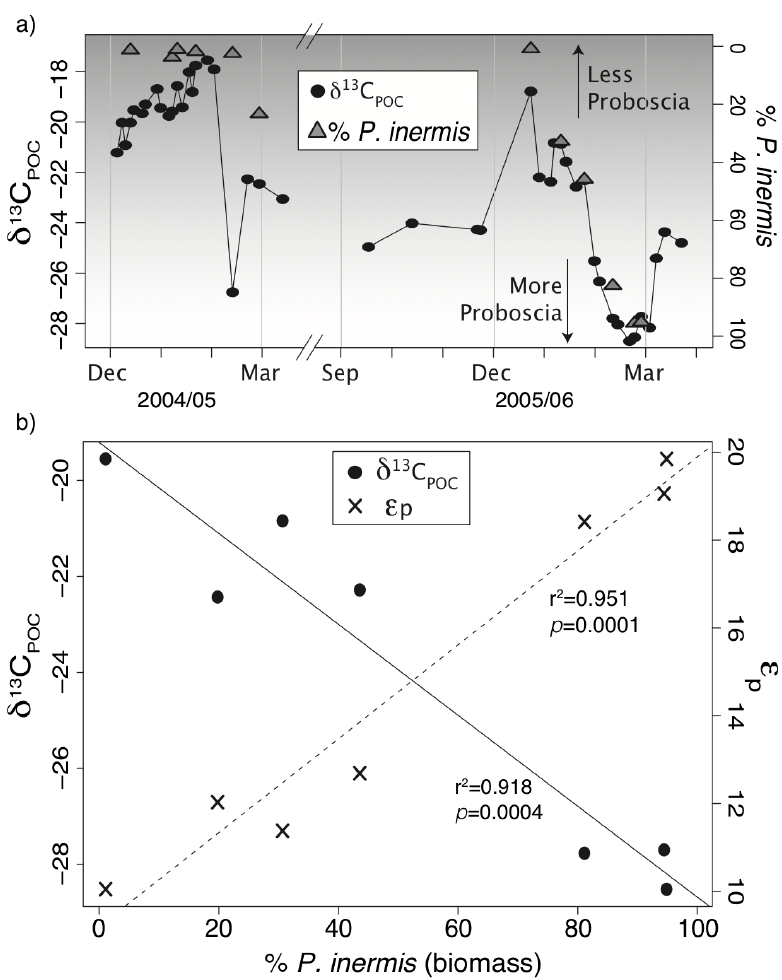
Fig. 10. Comparison of the fraction of surface water diatom biomass made up of P. inermis (triangles), δ 13 C POC (circles; solid line) and ε p (crosses; dashed line) for 2004/05 and 2005/06. Time-series data is shown in (a) , note the reversal of the right hand y-axis (% P. inermis ) to better illustrate the coupling between P. inermis biomass and δ 13 C POC . Variation of δ 13 C POC and ε p vs. P. inermis biomass for all 2005/6 samples and the only sample from 2004/5 where P. inermis accounts for > 2% of total biomass are shown in (b)